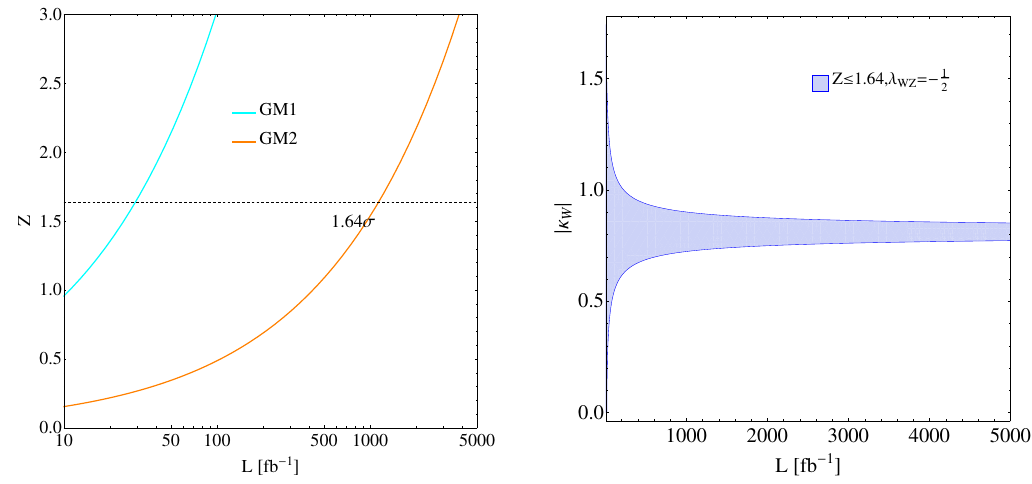
Figure 10 . Power to discriminate (cid:21) WZ = for scheme B at the 500-GeV ILC with the beam polarization P ( e (cid:0) ; e + ) = ( discriminating the GM1 and GM2 scenarios from the SM. Right: the assumption of (cid:21) WZ = can be distinguished from the SM assumption of (cid:21) WZ = 1 at 95% C.L. for a varying the blue